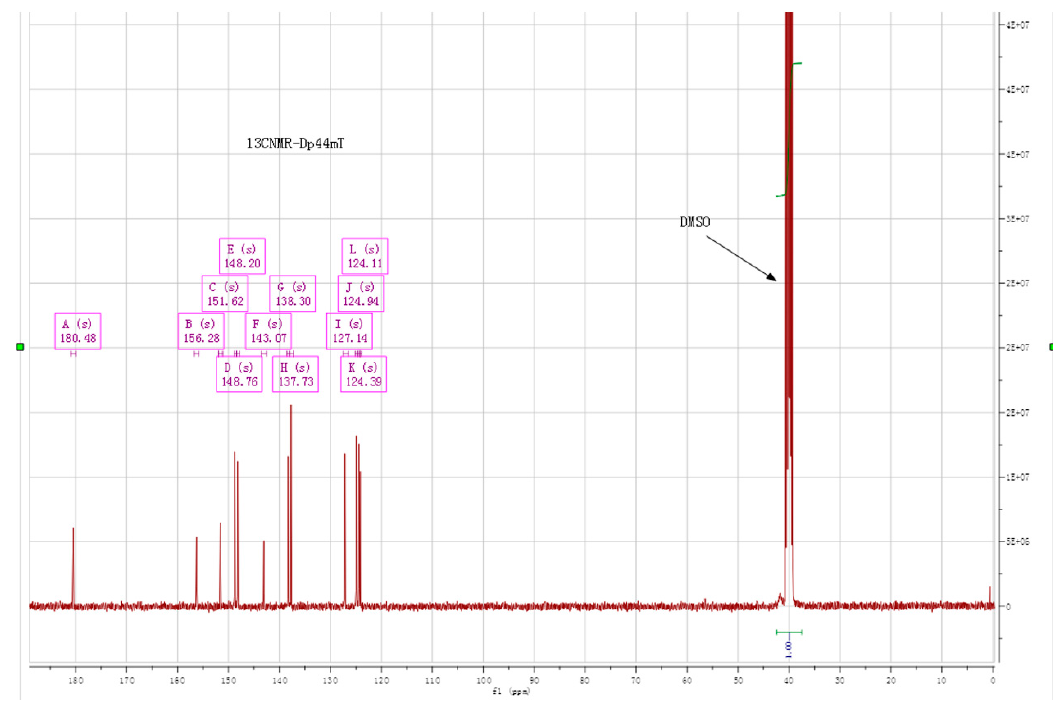
Figure C4. 13 C-NMR of Dp44mT and peak assignment.